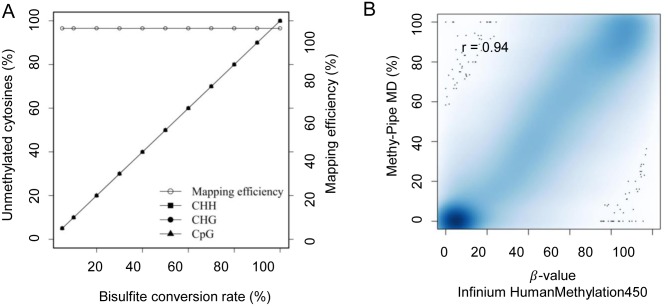
Performance evaluation of Methy-Pipe.(A) A total of 1 million reads (75 bases) were randomly simulated with different rates of bisulfite conversion and aligned to human (GRCh37/hg19) genome. Methy-Pipe accurately detected various simulated methylation levels at a constant mapping efficiency which is not affected by the sequence context. The H (in CHG and CHH) denotes C, T, or A. (B) Density scatter plots are plotted to measure the correlation between the MDs from Methy-Pipe and the β value from Infinium Human Methylationa450 array for CpG loci that can be integrated by both sequencing and array platforms from Placenta.